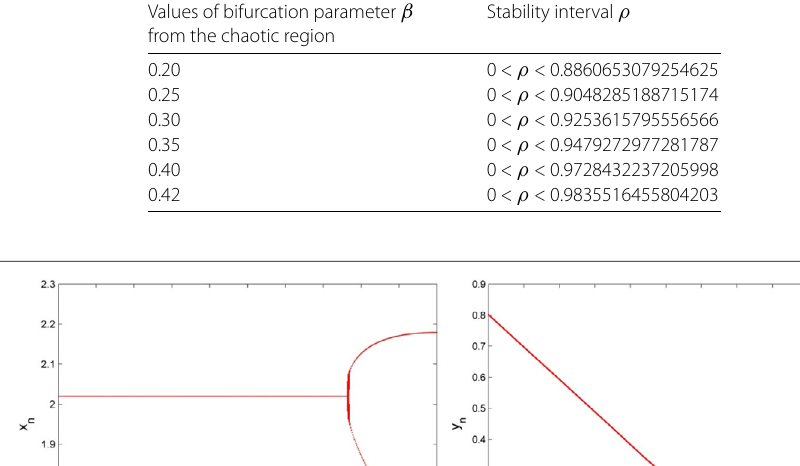
same for each case. Finally, interesing local implication diagrams and the plot of the con- trolled system are plotted in Fig.